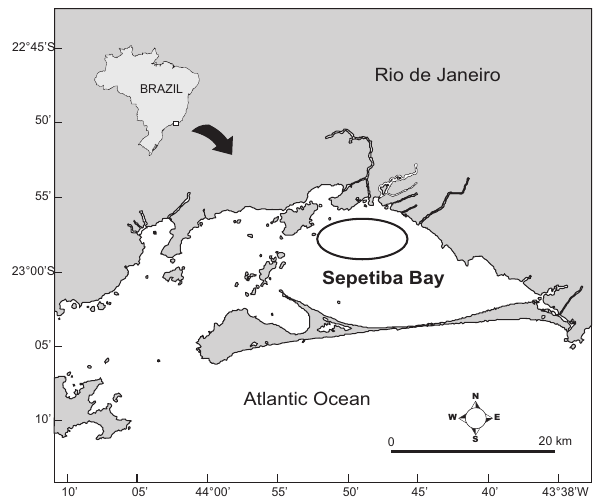
Figure 1. Sampling area (inner zone) of M. liza in the Sepetiba